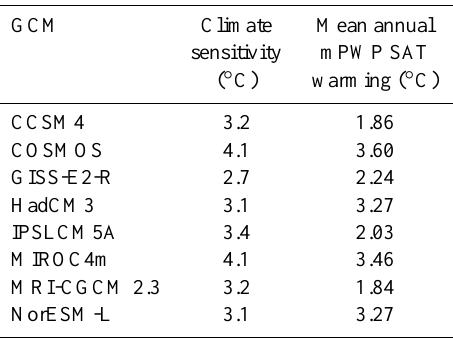
Table 2. The climate sensitivity and global mean annual surface air temperature warming of each of the models with simulations in the PlioMIP Experiment 2 ensemble. Climate sensitivity is the equilibrium global warming for a doubling of atmospheric CO 2 – the values quoted here are a general value for each model and do not refer to the particular set-up and initialization procedures used for